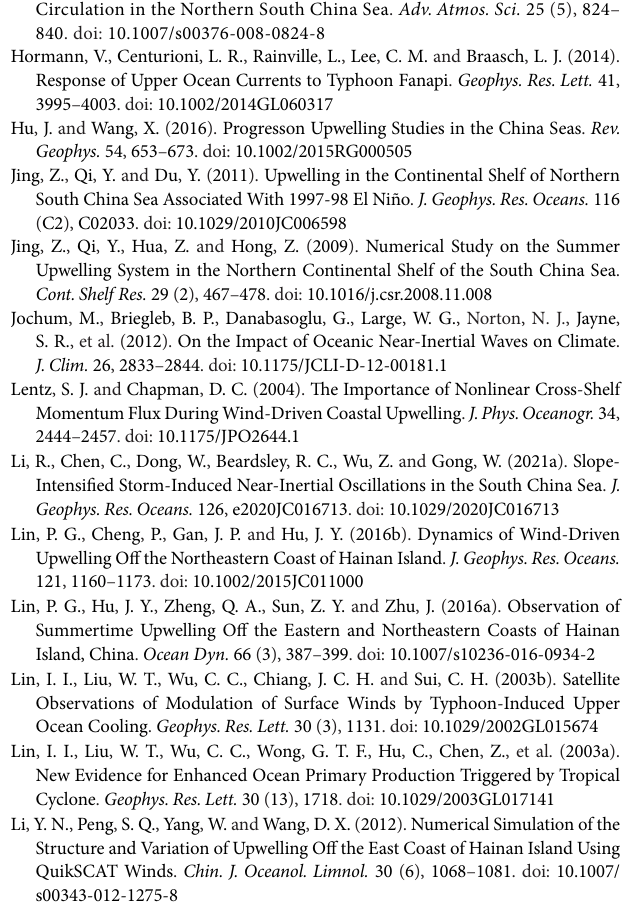
Supplementary Figure 1 | Model grid (left) and observation stations (right) during 2015 summer cruise. The cruise observations off the EHI were conducted from July 29 to August 7, 2015, and the Argos profiles in the northwestern Pacific are labeled in left panel. Supplementary Figure 2 | Comparisons of observed (A–E) and modeled (F–J) temperature profiles across the shelf off the EHI. Model results are interpolated to the stations along S1, S4, S5, S6, and S8 transects. Supplementary Figure 3 | Same as Supplementary Figure 2 , except for salinity. (A–E) observed salinity profiles; (F–J) modeled salinity profiles. Supplementary Figure 4 | Comparisons of modeled (red lines) and Argos (blue dotted lines) vertical temperature profiles. The observation date for these profiles are (A) Aug-13, (B) Dec-30, (C) Nov-23, (D) Aug-25, (E) Aug- 27 and (F) Aug-8, 2015. Supplementary Figure 5 | Same as Supplementary Figure 4 , except for the